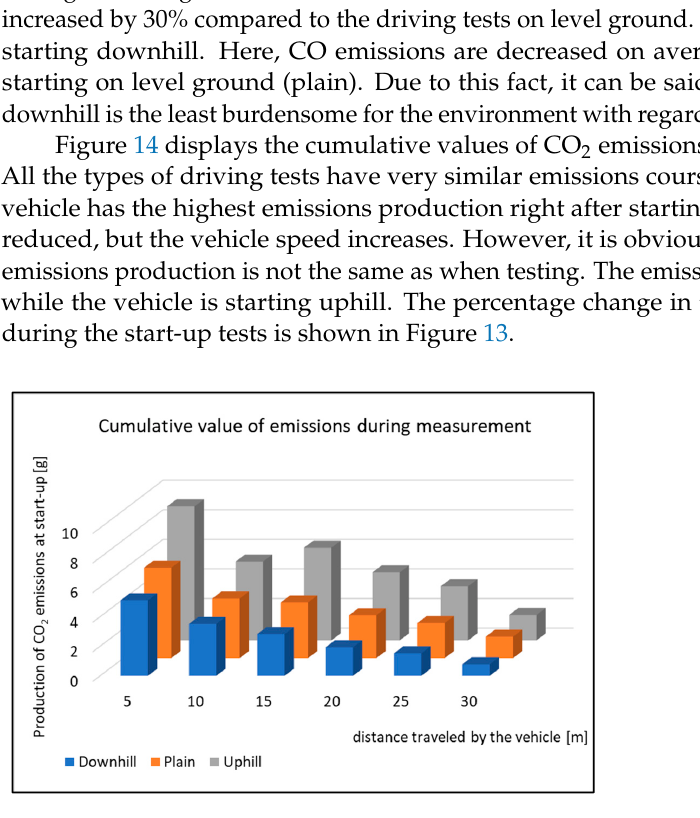
Figure 13. Change in emissions production compared to starting up on plain.